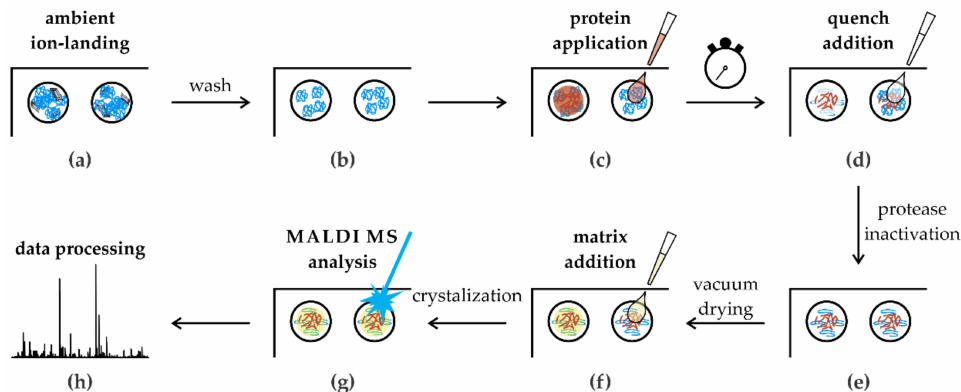
Figure 5. Scheme of the in situ limited proteolysis workflow. ( a ) Protease spots containing solvent impurities; ( b ) only ion-landed molecules remained on spots after the wash; ( c ) protein sample deposition on the dried spots; ( d ) proteolytic reaction was stopped after the incubation time by acidification; ( e ) quenched reaction mixture was dried in vacuum; ( f ) all spots were overlaid by the MALDI matrix solution; ( g ) MALDI MS analysis; ( h ) semiautomatic data